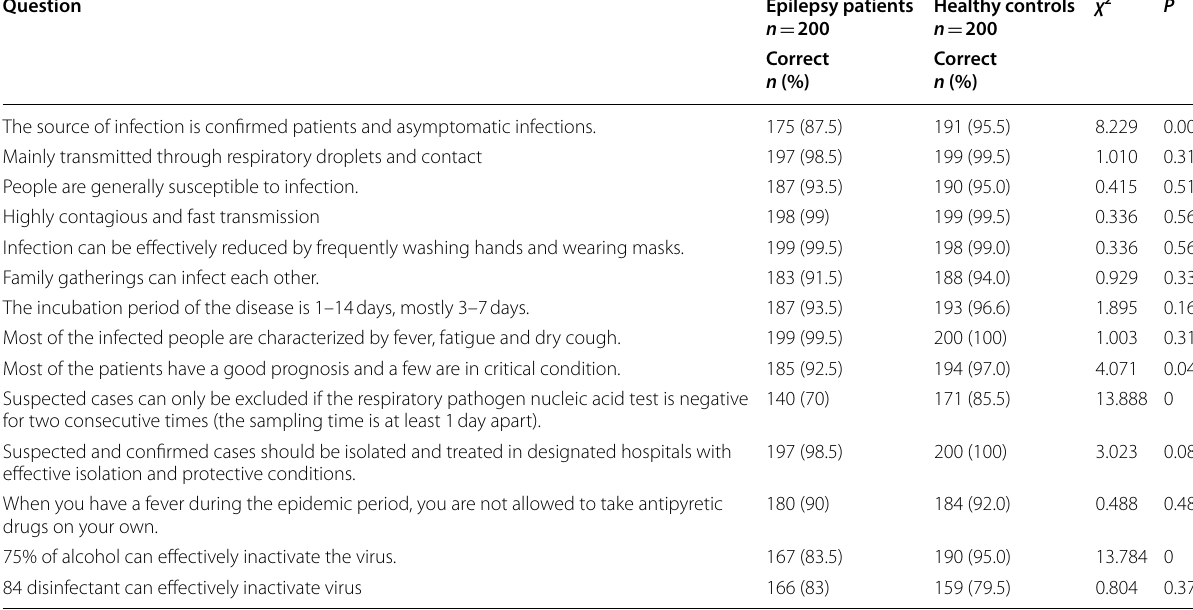
Table 6 Comparison of knowledge regarding COVID-19 between the two groups Question Epilepsy patients